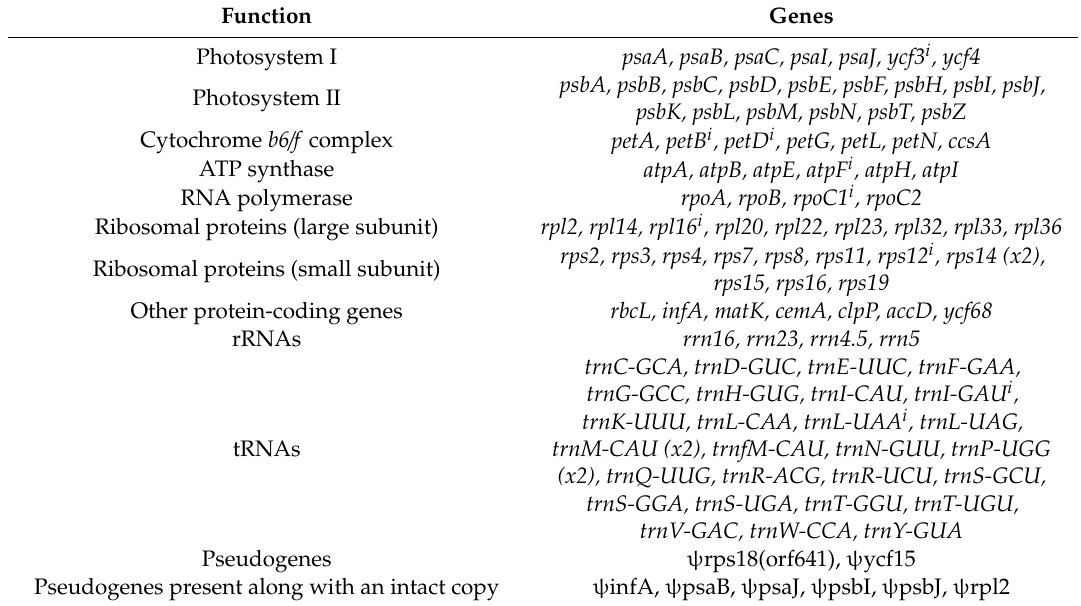
Table 1. Summary of genes identified in the D. rotundifolia plastome.